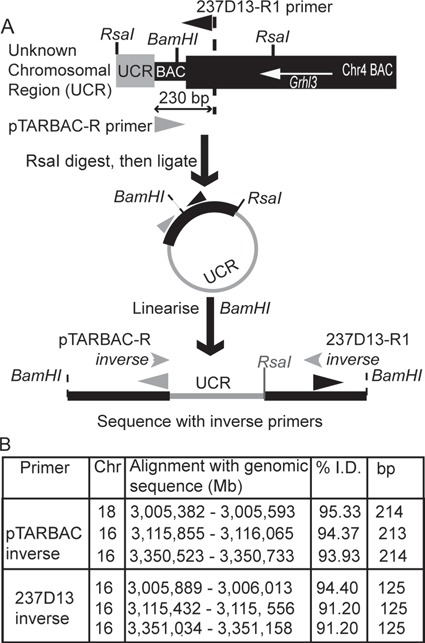
Localization of BAC-transgene in Grhl3ct/ct;TgGrhl3/0 embryos. (A) Inverse PCR was used to isolate genomic fragments adjacent to the insertion site of the Grhl3-containing BAC. (B) Sequence tags most closely aligned to the reference genomic sequence in a region on chromosome 18 with insertion of the BAC at 18: 3,005,382 in a low complexity repeat. Inverse PCR fragments also show homology to regions on chromosome 16 but with lower identity.